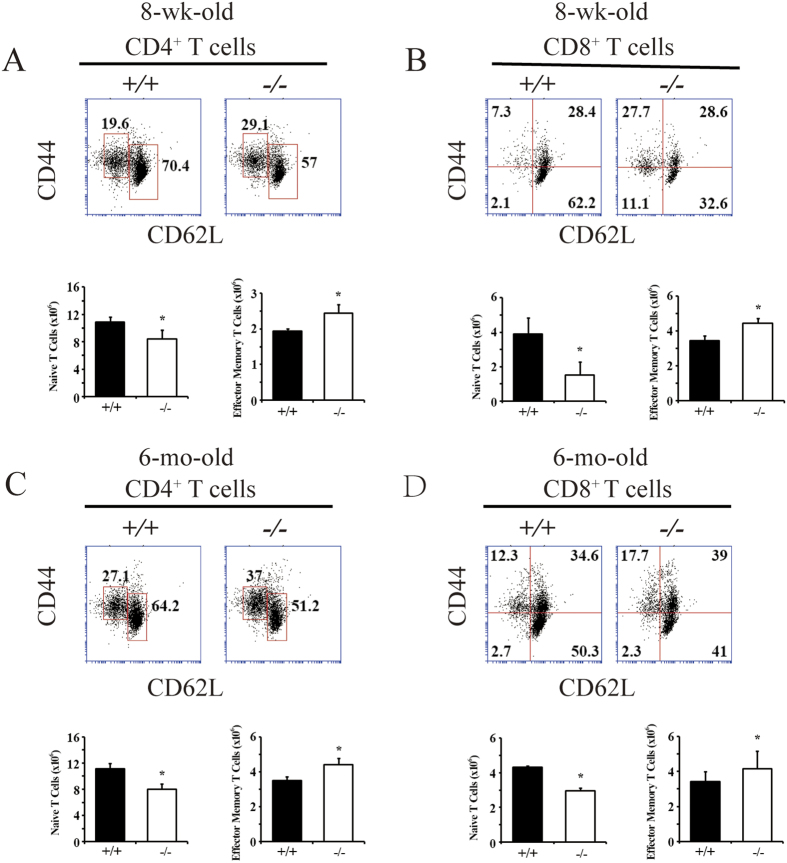
BAP31 regulates effector/memory T cells.Splenocytes were stained for CD4, CD8, CD44 and CD62L. CD4+ or CD8+ T cells were gated for CD44 and CD62L analysis. Flow cytometry analyses of the percentage of naïve (CD44lowCD62Lhi) and memory (CD44hiCD62Llow) CD4+ T cells (A,C) or the percentage of naïve (CD44low) and memory (CD44hi) CD8+ T cells (B,D) in the spleen of young (A and B; 8-wk-old) or older (C and D; 6-mo-old) BAP31+/+ and BAP31−/− mice. Data are presented as representative plots and summary graphs of the mean ± SD values of three independent experiments.